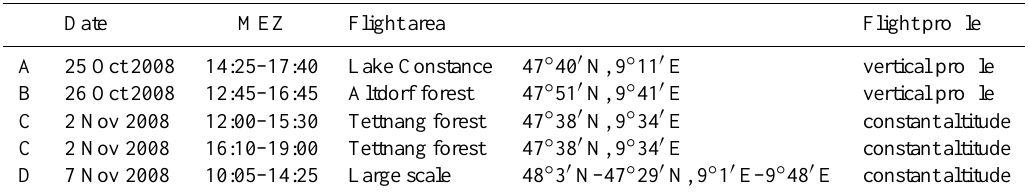
Table 1. Overview of the analysed flights.